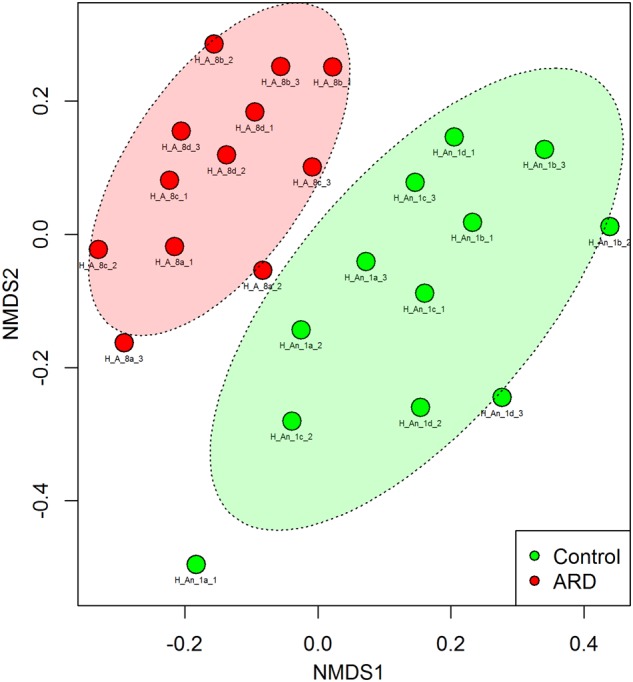
Non-metric multidimensional scaling (NMDS) based on Bray-Curtis similarities of nematode community structures from field plots replanted five times with apple or virgin control plots planted one time with apple, analyzed by high-throughput 18S rDNA amplicon sequencing from total nematode community DNA. PERMANOVA revealed a significant difference in the overall nematode community structure between ARD and control soils (P < 0.001, Stress = 0.246). The site had four plots per treatment randomly arranged. From each plot, soil was sampled around roots of three individual plants for extraction of nematodes to obtain total community DNA. Labels: site Heidgraben (H), replanted apple plot (A_8) or new apple plot (An_1), replicate plot (a, b, c, and d), soil subsample from individual root system (1, 2, and 3).